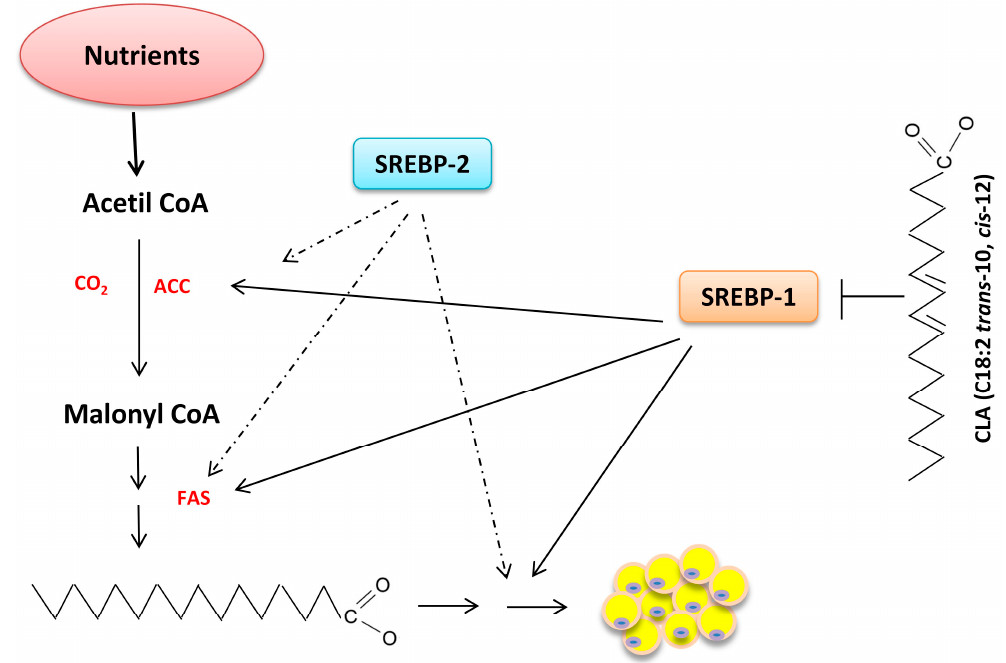
Figure 4. Proposed mechanism for the effect of fatty acids on the regulation of key enzymes in lipogenesis via SREBPs (solid arrows indicate greater effects; dotted arrows indicate lesser effects). SREBP: sterol regulatory element-binding protein, ACC: acetyl-CoA carboxylase, FAS: fatty acid synthase, CLA: conjugated linoleic acid.